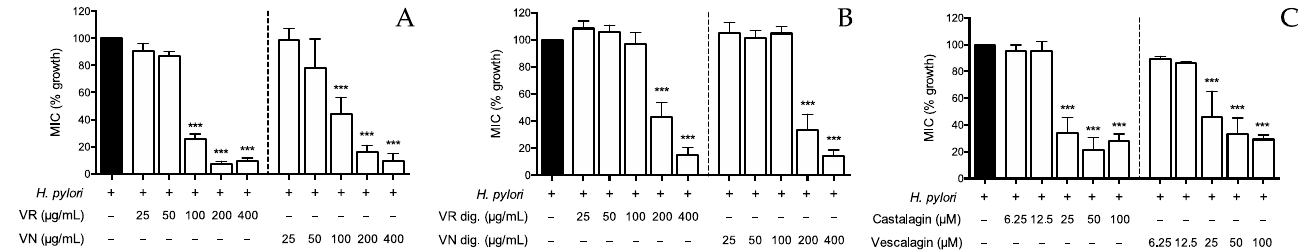
Figure 6. Effect of Castanea sativa Mill. leaf extracts and ellagitannins on H. pylori growth. H. pylori (OD = 0.1) was treated for 72 h with leaf extracts before ( A ) and after ( B ) in vitro simulated digestion, or ellagitannins ( C ). The rate of bacterial growth was measured as optical density (600 nm) using a photometer. Results are expressed as the mean ± SEM ( n = 3) of the relative percentage in comparison to H. pylori growth (black bar), to which the value of 100% was arbitrarily assigned. *** p < 0.001 vs. H. pylori . MIC, minimum inhibitory concentration; VR, Castanea sativa Mill. var. verdesa leaf extract; VN, Castanea sativa Mill. var. venegon leaf extract; dig., in vitro simulated digestion.